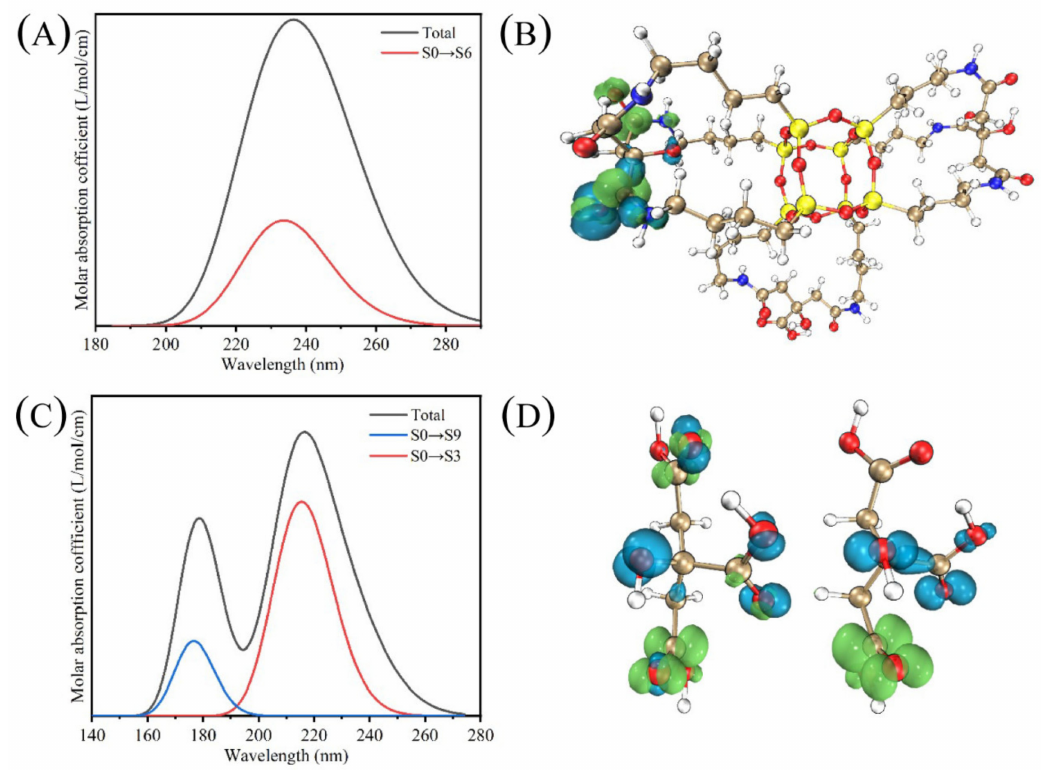
Figure 6. Simulated electronic absorption spectrum ( A ) and real space representation of hole and electron distribution for S0 → S6 of CAP ( B ); simulated electronic absorption spectrum ( C ) and real space representation of hole and electron distribution for S0 → S9 and S0 → S3 of CAP ( D